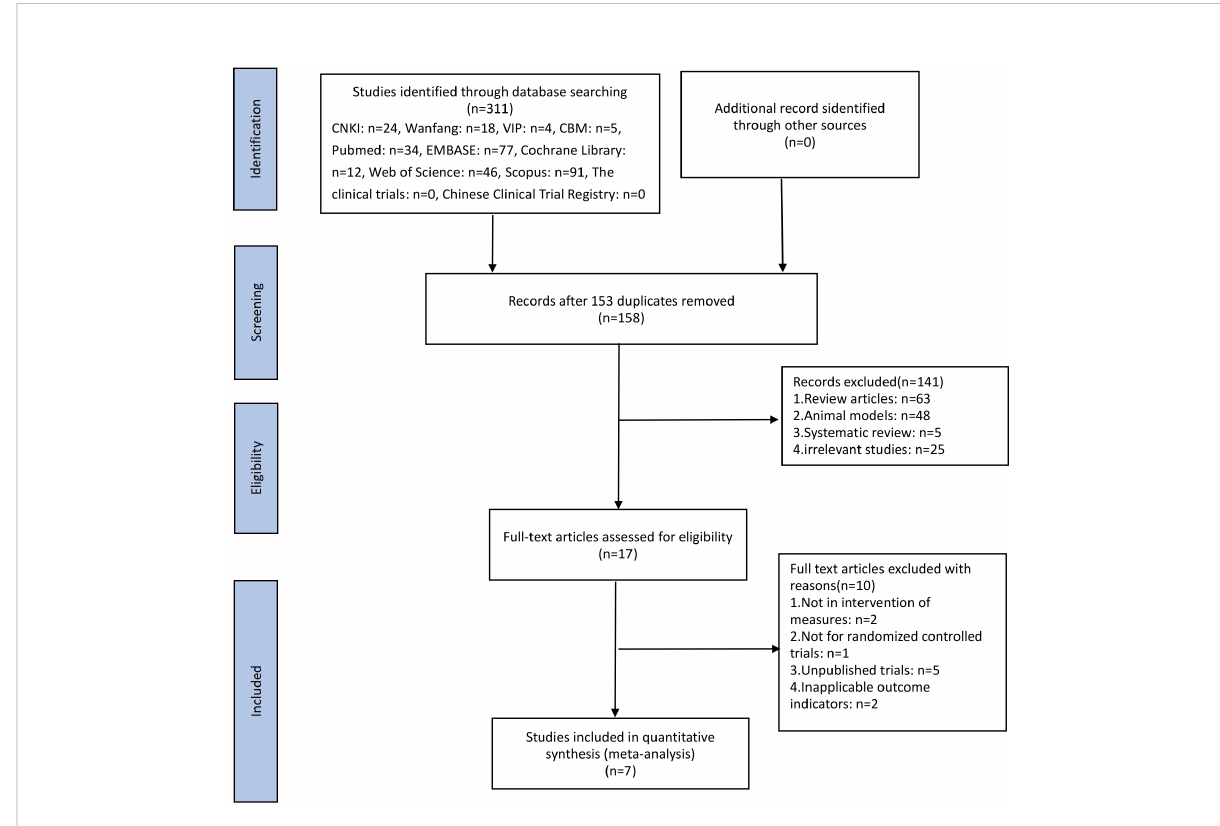
FIGURE 1 Flow diagram of the study selection